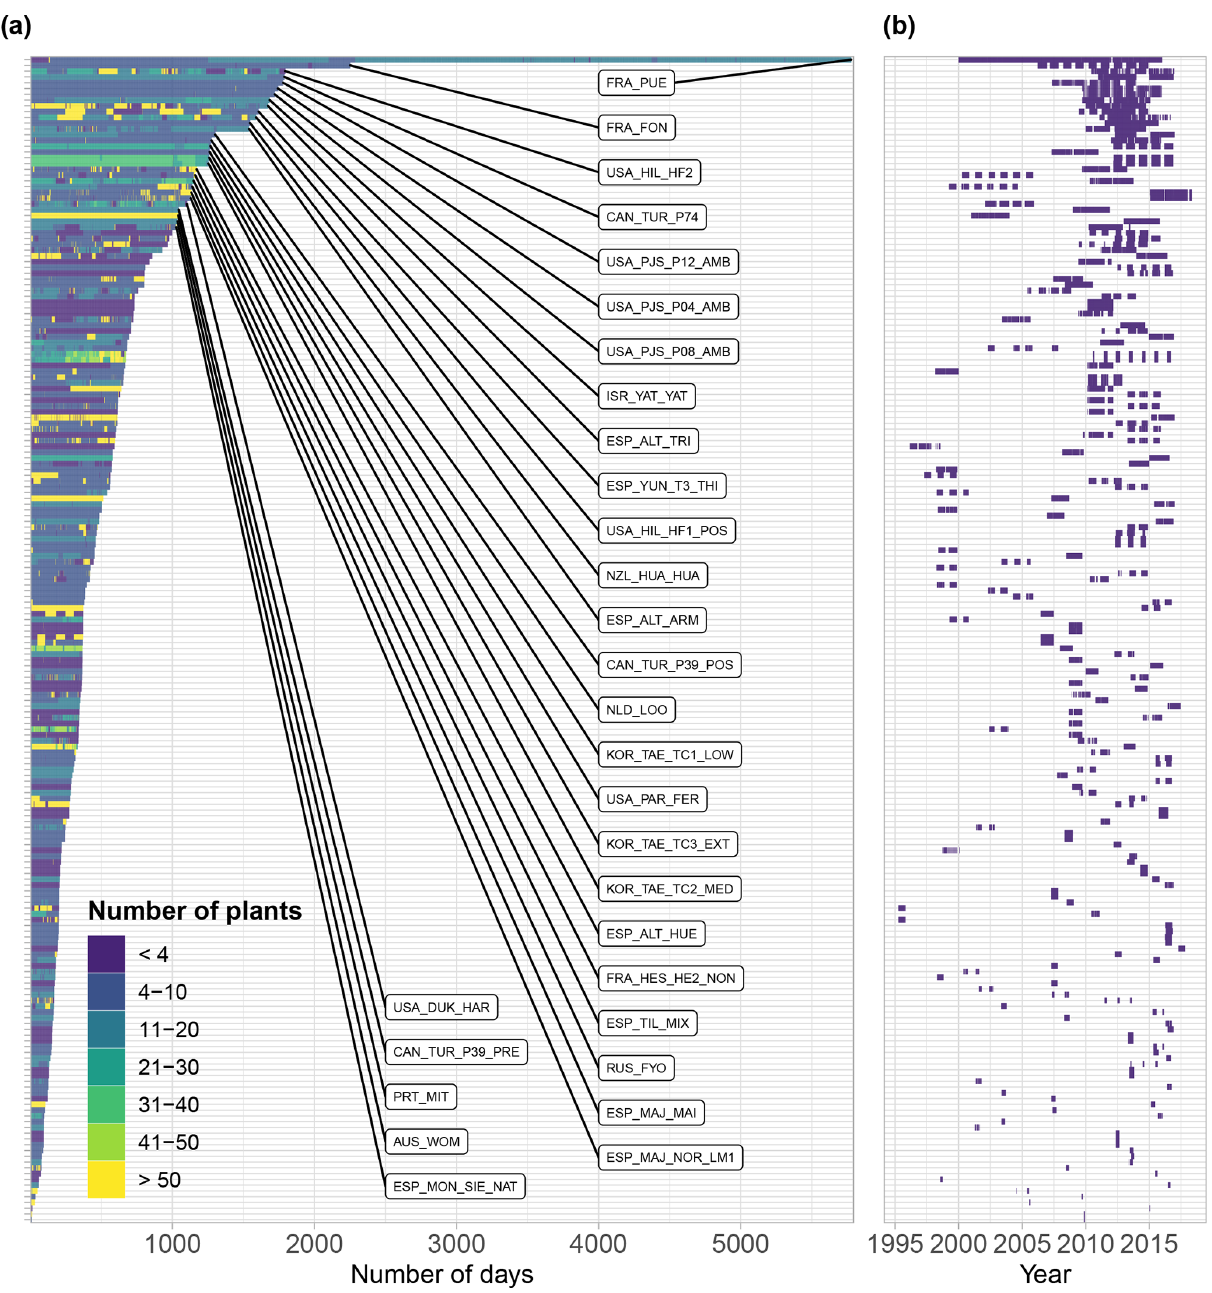
Figure 6. (a) Measurement duration of SAPFLUXNET datasets expressed in number of days with sap flow data and coloured by the number of plants measured on each day. The 30 longest datasets are labelled. For each dataset in panel (a) , panel (b) shows its corresponding measurement